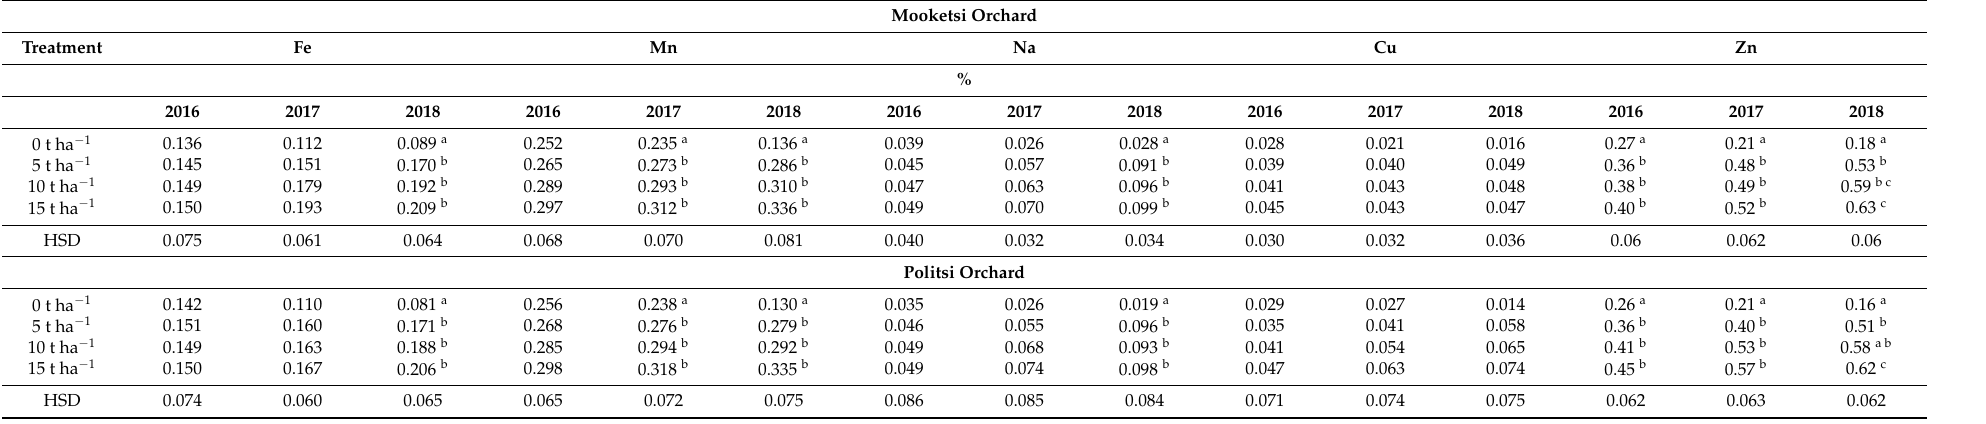
Table 4. Leaf Fe, Mn, Na, Cu, and Zn contents as influenced by compost application rates over a three-year study (2016–2018) at the Mooketsi and Politsi